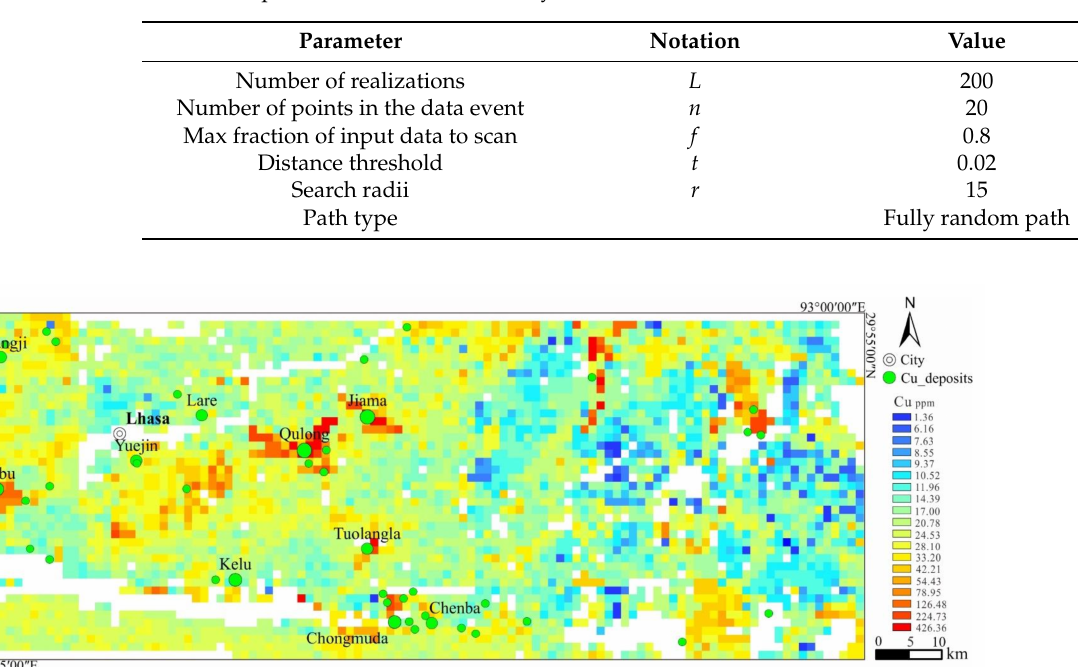
Table 2. DS parameters for the case study.